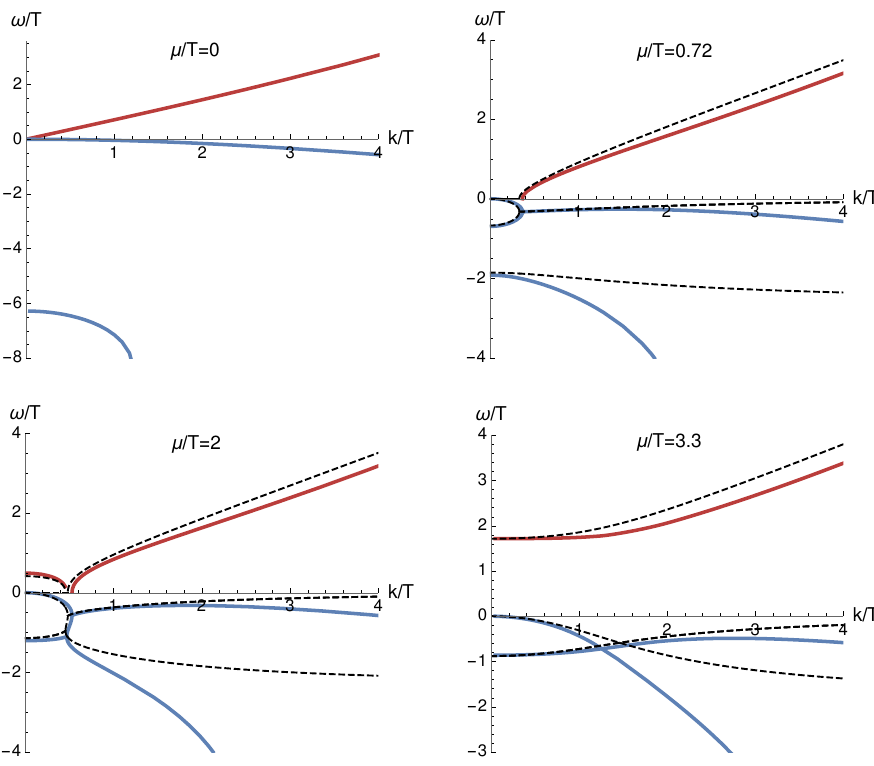
Figure 6 . Real (red) and imaginary (blue) parts of the lowest, longitudinal, collective modes in the Reissner-Nordstr(cid:127)om geometry when increasing (cid:22)=T at (cid:12)xed (cid:21) = 1. Colored lines represent numerical data and dashed-black the (cid:12)t to formula (4.6). The hydrodynamic formula (cid:12)ts well the data in the regime !=T; k=T (cid:28)